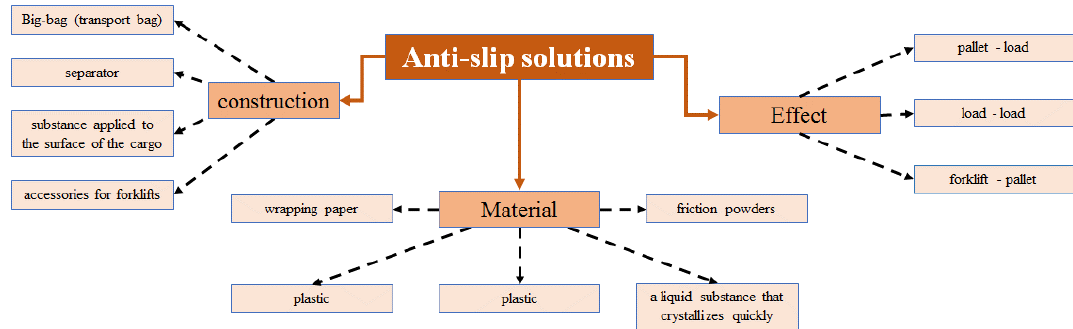
Figure 6. Anti-slip and load-stabilizing solutions in logistics.